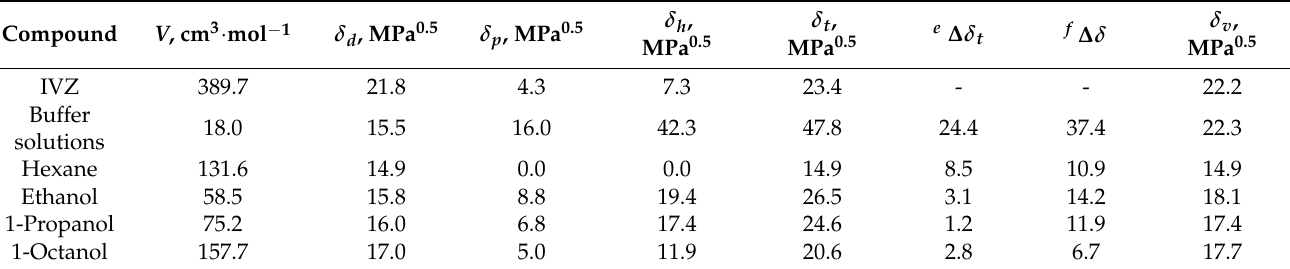
Table 3. Molar volumes and Hansen solubility parameters for IVZ and selected solvents.